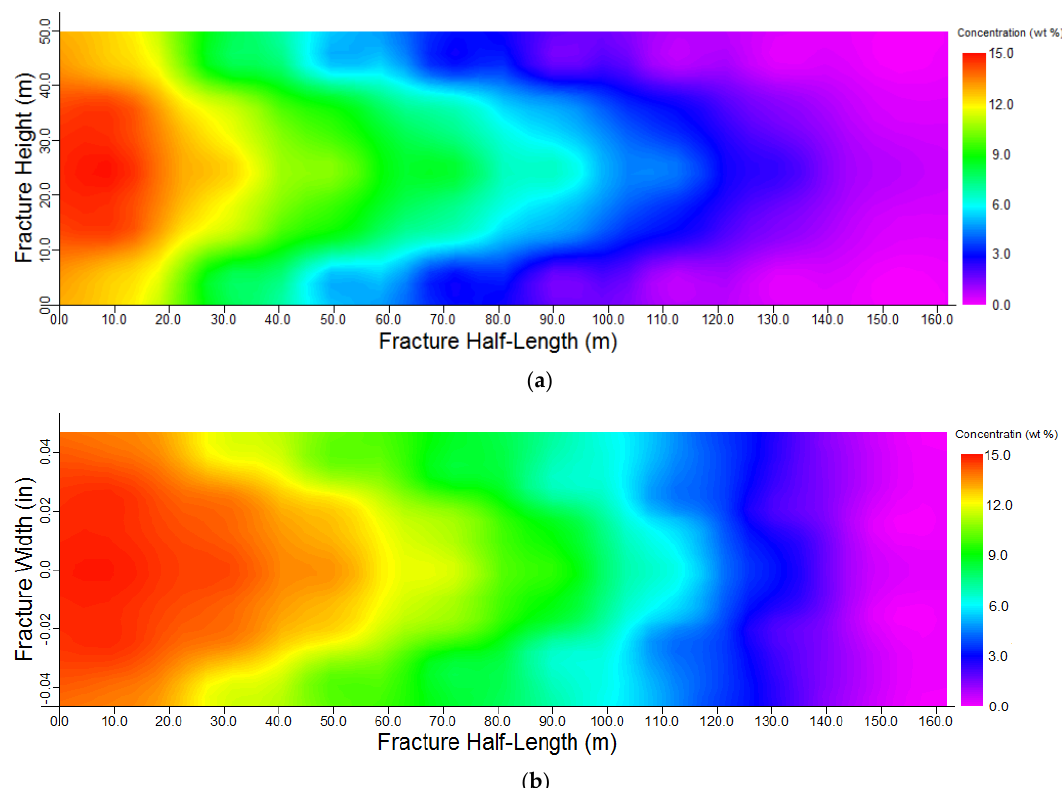
Figure 4. Simulated acid concentration within the fracture domain for a flow rate of 10 bbl/min and 400 bbl acid volume. ( a ) fracture half-length vs. height ( b ) fracture half-length vs. width.